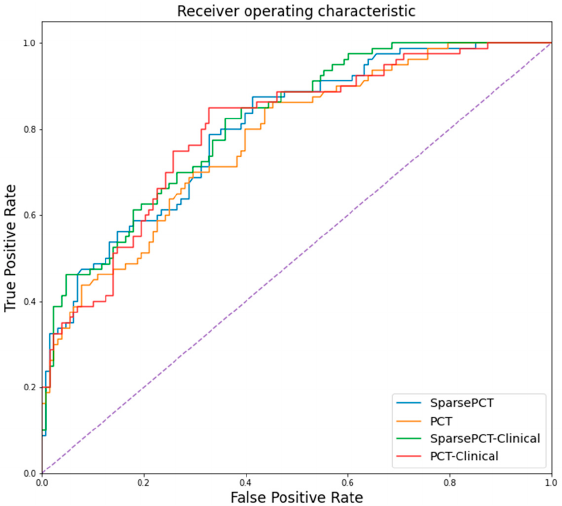
Figure 6. Receiver operating characteristic (ROC) curve for different multivariate model using deep thermomic features and clinical and demographic information is presented for classifying between symptomatic and non-symptomatic participants (for baseline model). Table 2. The results of random forest classification for the cross-validated model.